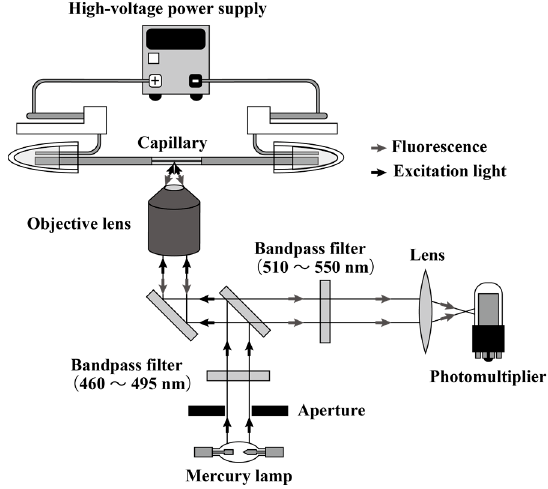
Figure 1. Schematic illustration of the capillary gel electrophoresis (CGE) instrument.